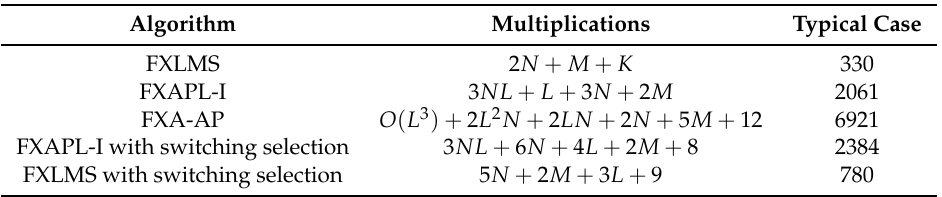
Table 1. Number of multiplications per iteration of the FXLMS, FXAPL-I, FXA-AP, FXAPL-I with switching selection and FXLMS with switching selection algorithms for a single-channel ANC system. Typical case: M = 128, N = 100 and L = 5.